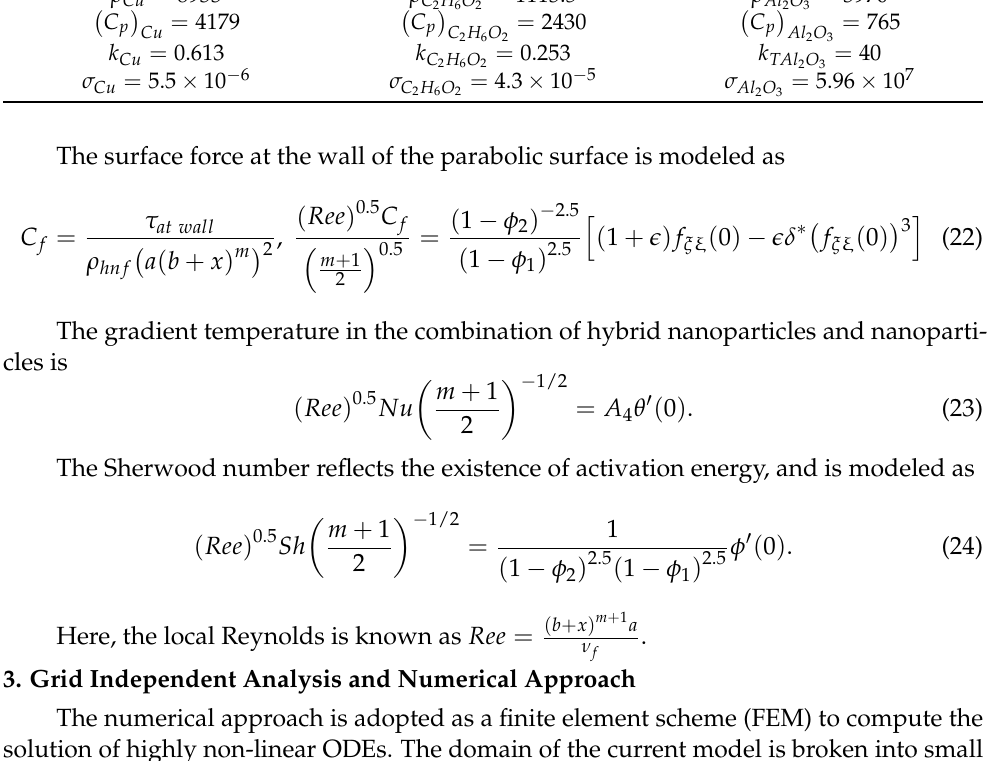
Table 1. Thermal properties of hybrid nanoparticles and nanoparticles in base fluid. Cu C 2 H 6 O